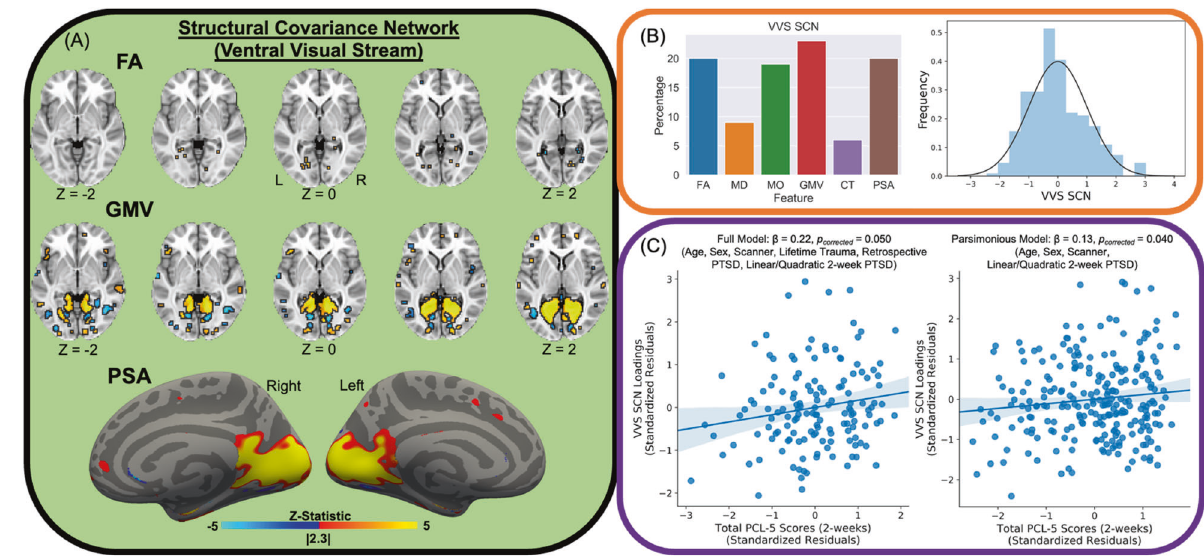
Fig. 1 Structural covariance network of the ventral visual stream and acute PTSD severity. Linked independent components analysis (LICA) was completed on fractional anisotropy (FA), mean diffusivity (MD), mode of the diffusion tensor (MO), gray matter volume (GMV), cortical thickness (CT), and pial surface area (PSA) spatial maps to derive multimodal components. We observed a component that re fl ected a structural analog of the ventral visual stream derived from all participants ( A ). The component predominantly re fl ected FA, GMV, and PSA of the visual cortex, anterior temporal lobe, and the inferior fronto-occipital fasciculus (left) and the distribution of loadings across participants (right) ( B ). The component was related to total scores on the PTSD Checklist for DSM-5 (PCL-5) in both full (left) and parsimonious (right) models described in the “ Methods ” section ( C ). Brain fi gures represent the ventral visual stream structural covariance network obtained from LICA across all participants. Scatter plots are partial plots where dots represent the standardized residuals of individual participant loadings and PCL-5 scores. Lines represent the linear line of best fi t and the shaded bar represents the 95% con fi dence